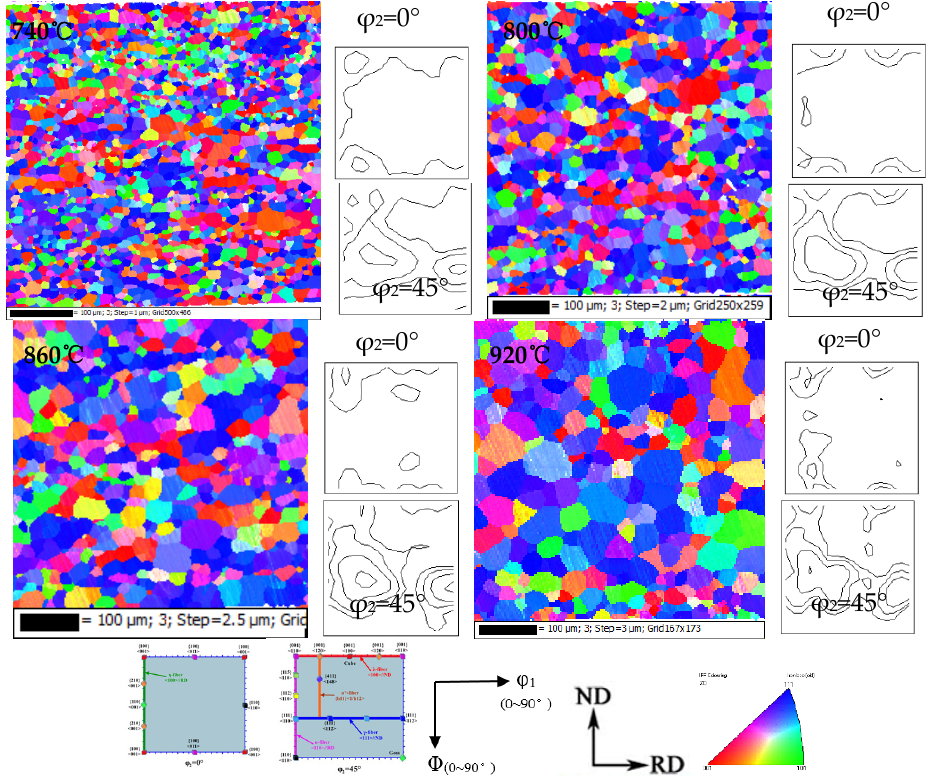
Figure 9. EBSD inverse pole figure (IPF) maps, ϕ 2 = 0 ◦ and ϕ 2 = 45 ◦ ODF sections of Fe-0.65%Si non-oriented electrical steel annealed sheet during grain growth (levels: 1,2,4,8; deviation angle 15 ◦